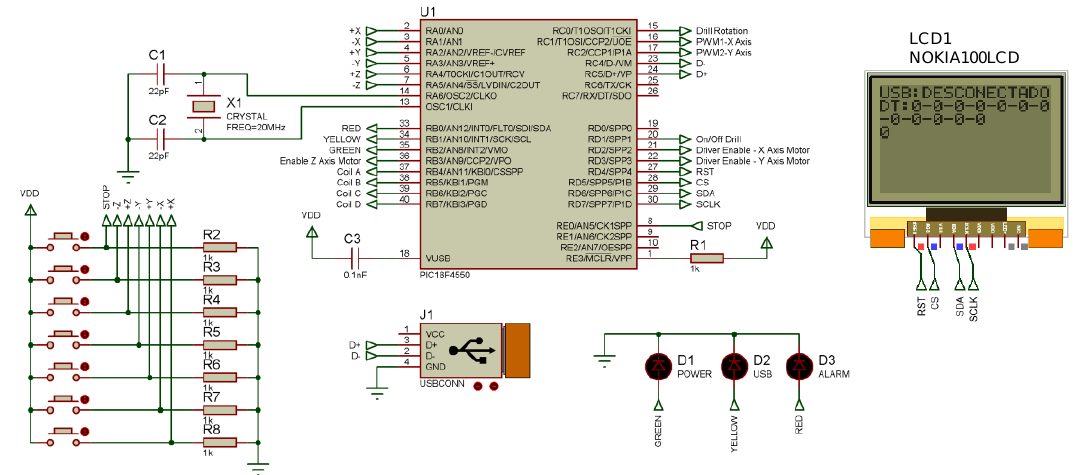
Figure 9. Schematic diagram of the control stage.